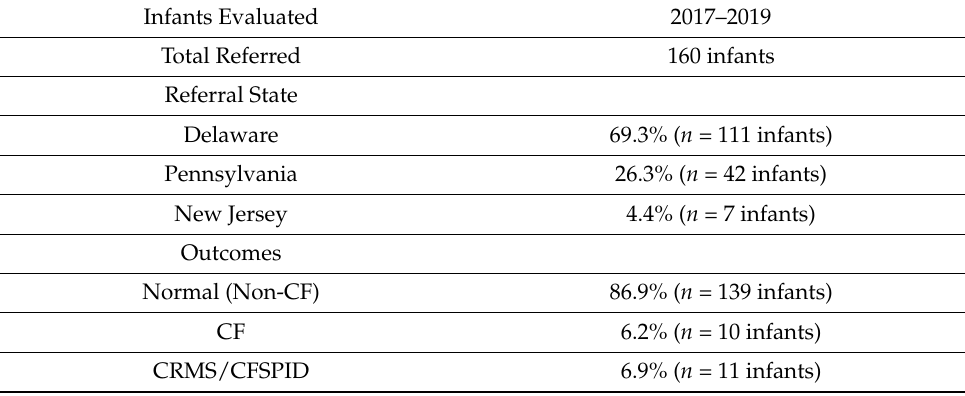
Table 2. Referral State of Infants with Abnormal Cystic Fibrosis (CF) Newborn Screening and Their